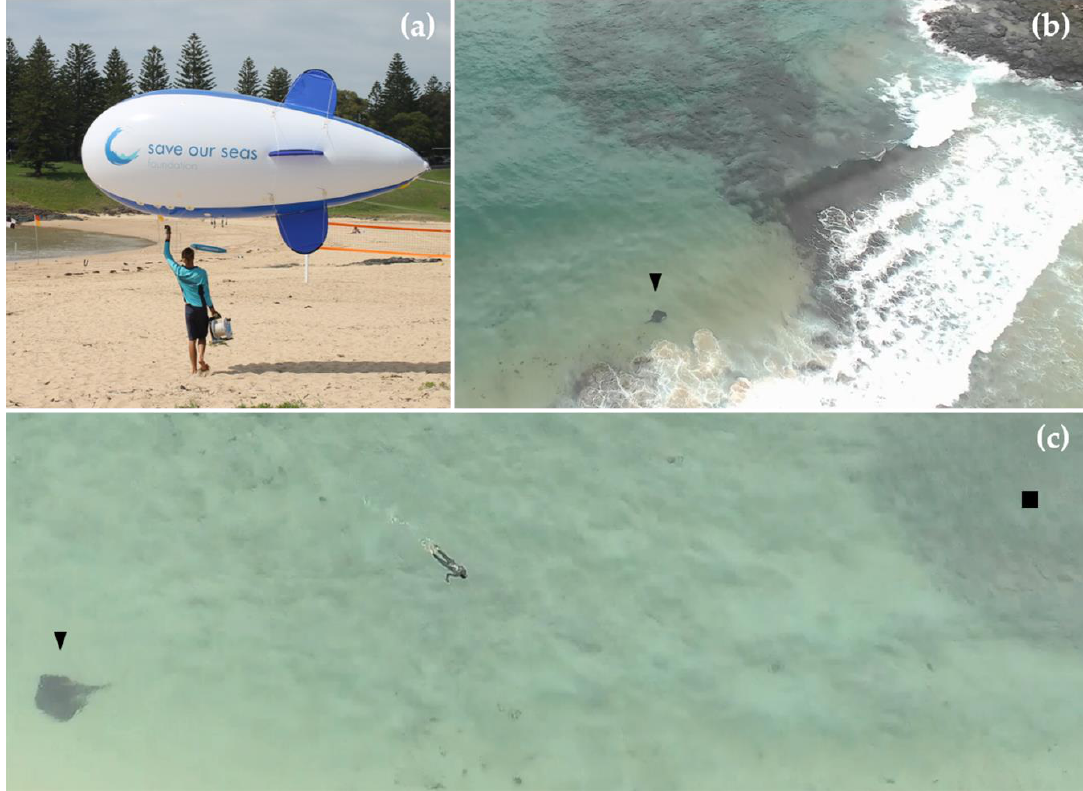
Figure 6. ( a ) Blimp used as aerial platform for conducting video surveillance; ( b ) Example of image taken from the blimp in which it is possible to determine the position of a stingray ( ▼ ) in reference to the broad view of the bay; ( c ) zoomed picture of a stingray ( ▼ ) swimming in close proximity to a swimmer and a school of Australian salmon ( Arripis trutta ) ( ■